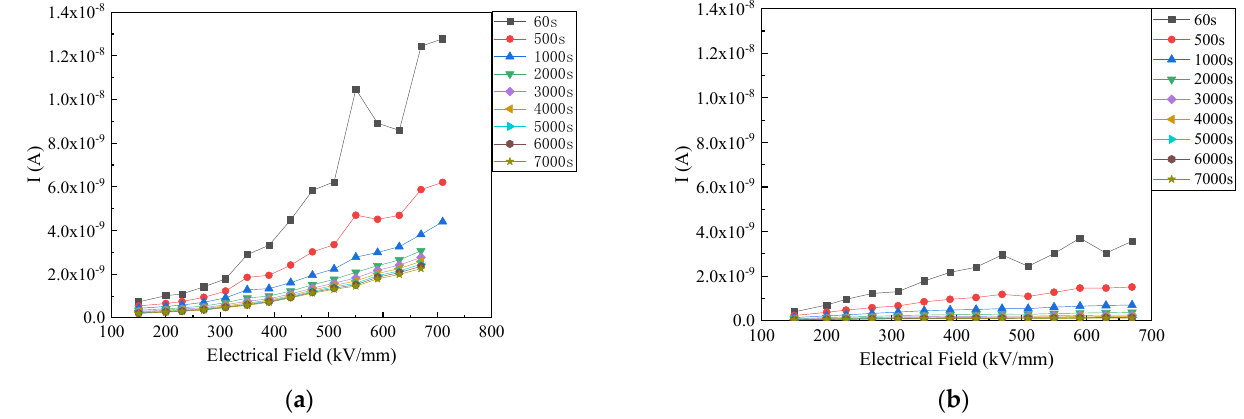
Figure 3. The variation trend of charging and discharging current versus electric fields. (( a ): The charging current versus electric field; ( b ): The discharging current versus electric field).